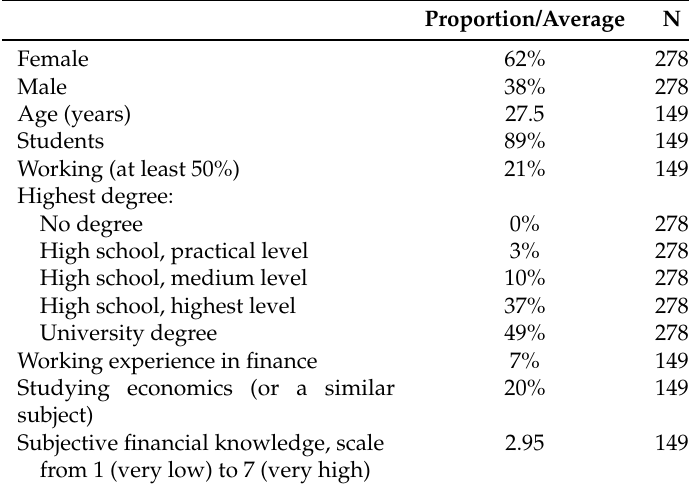
Table 1. Sample characteristics.